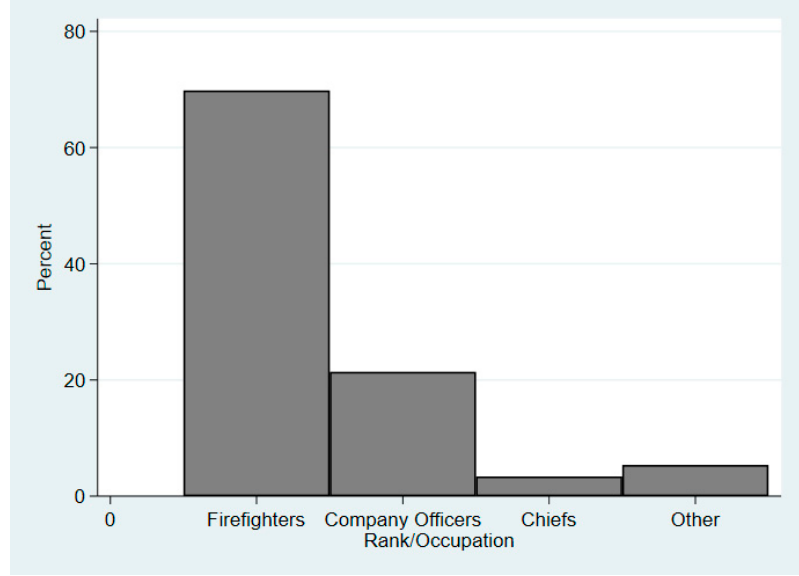
Figure 2. The combined rank/occupation distribution of firefighters from fire department 1 (western U.S.) and fire department 2 (eastern U.S.).